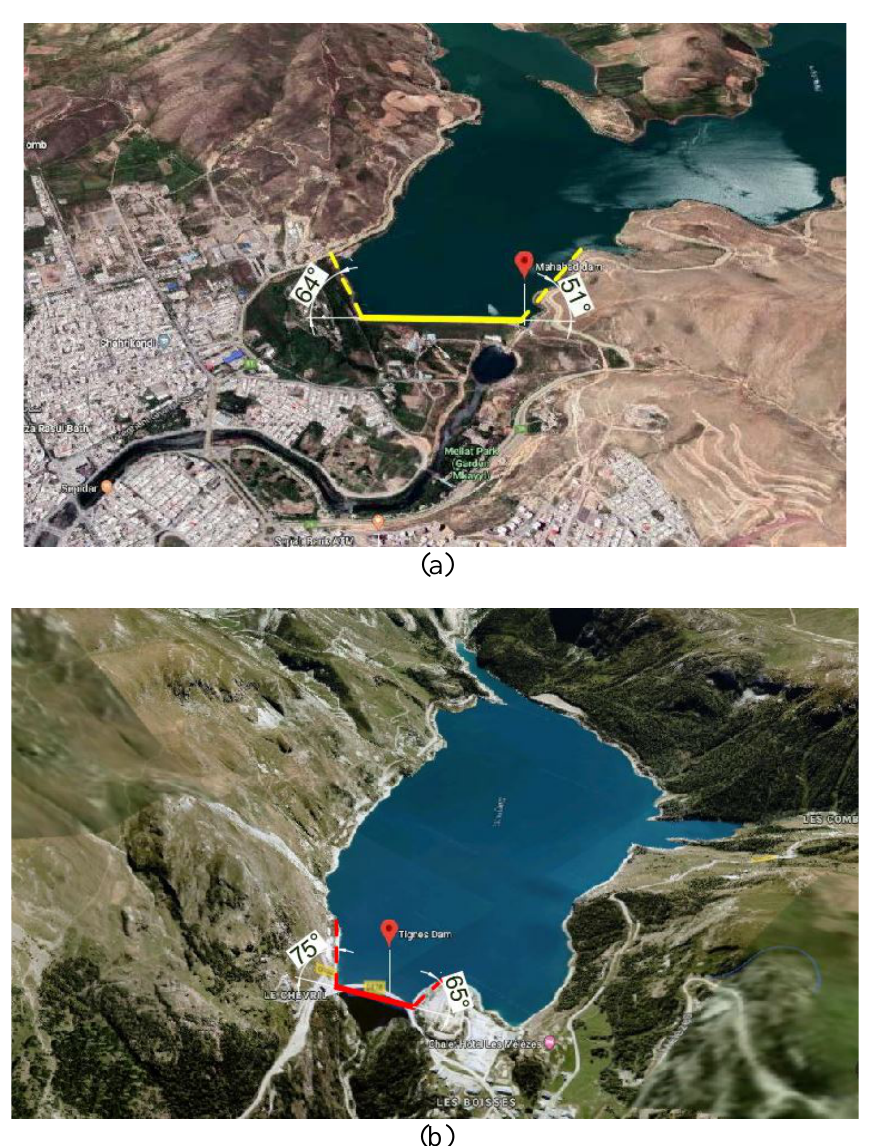
Fig. 2. Two case studies: (a) Mahabad Dam; (b) Tignes